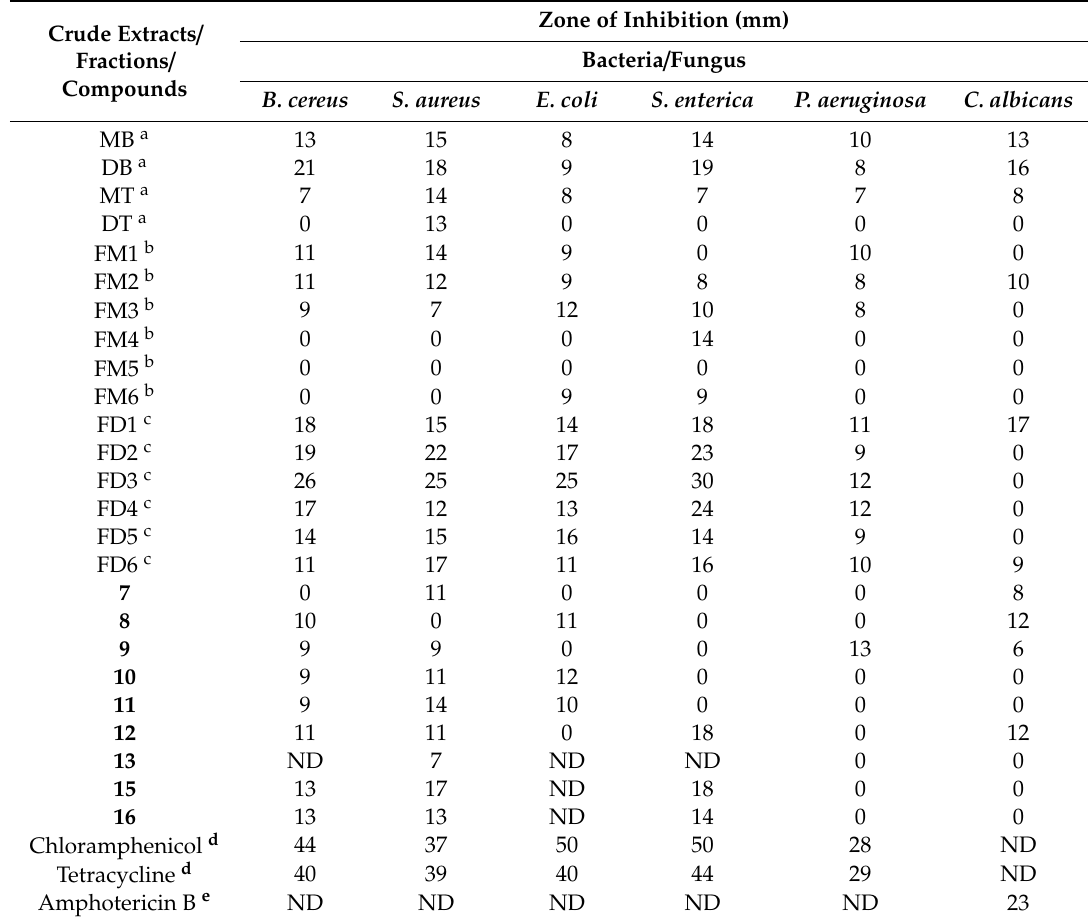
Table 3. Antibacterial and antifungal activities of crude extracts, fractions and isolated compounds. Crude Extracts / Fractions